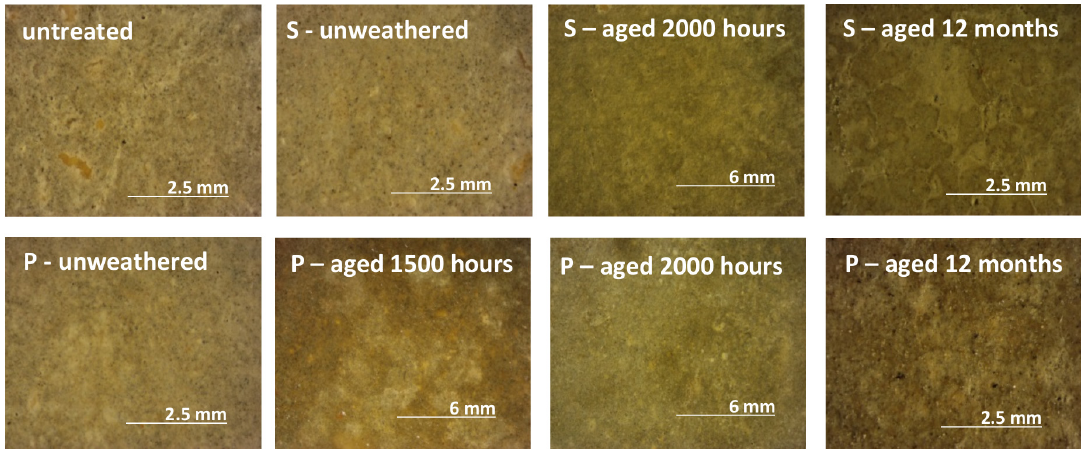
Figure 3. Stereo ‐ microscope images of the surface of concrete: untreated and treated with the permanent (P) and sacrificial (S) anti ‐ graffiti coatings before and after artificial and natural ageing; respectively after 1500 and 2000 h in a QUV chamber and after 12 months of outdoor exposure.